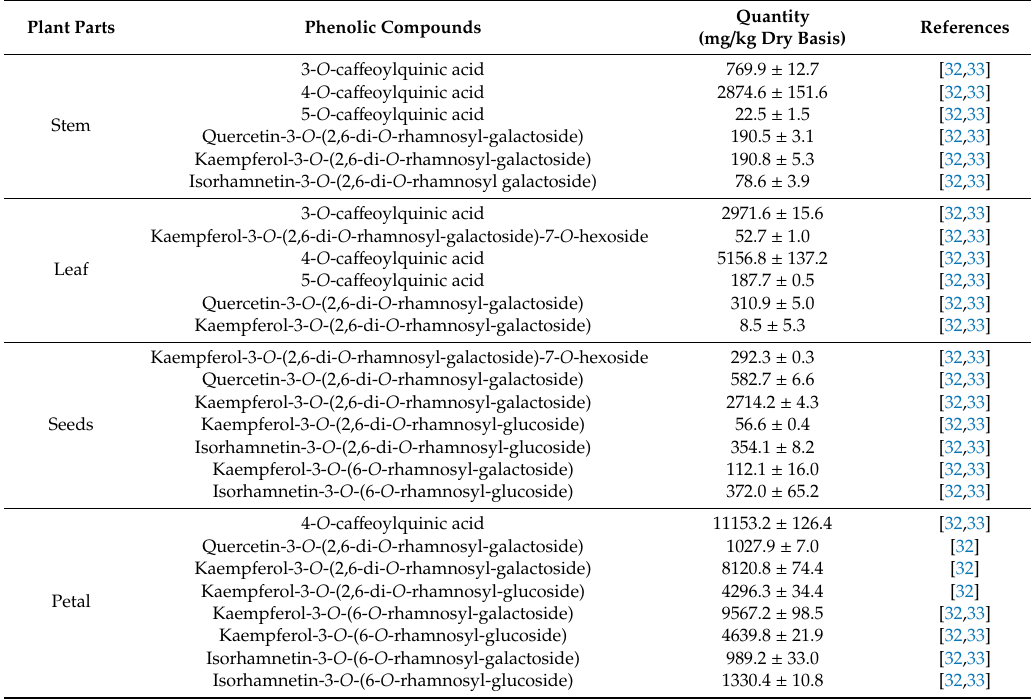
Table 3. Identified phenolic compounds in C. roseus .